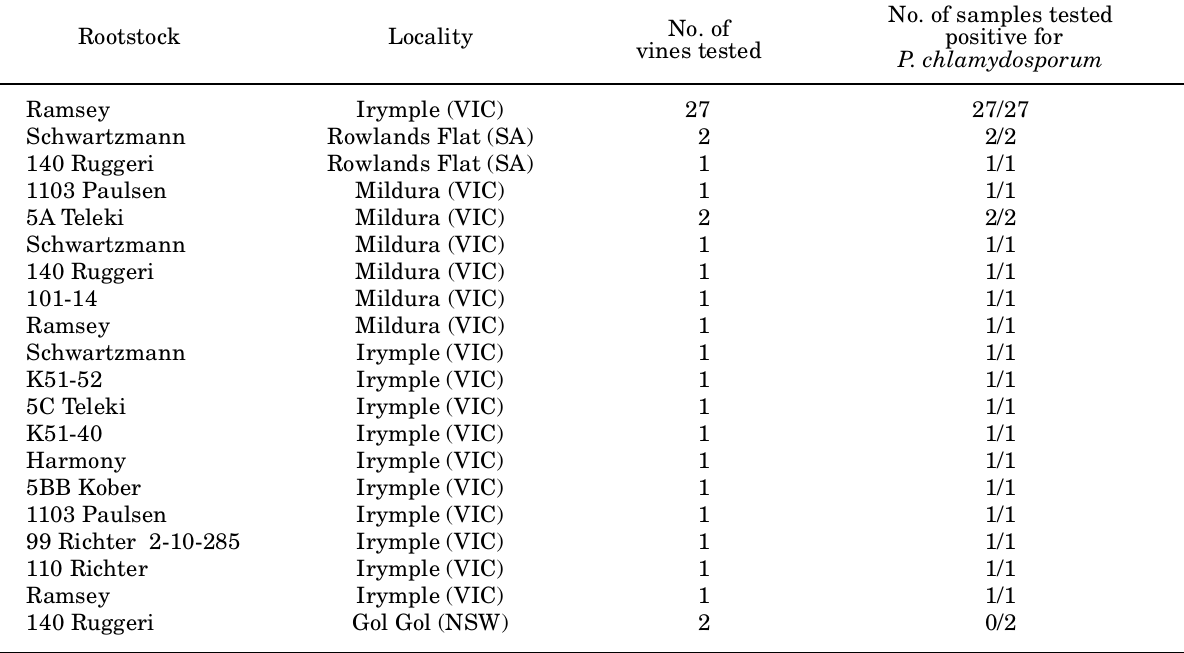
Table 1. Presence of Phaeoacremonium chlamydosporum in samples of rootstock material tested from 3 states in Australia (VIC=Victoria, SA=South Australia, NSW=New South Wales). Data has been obtained from grapevine material tested by Crop Health Services, Institute for Horticultural Development, Knoxfield, Victoria,